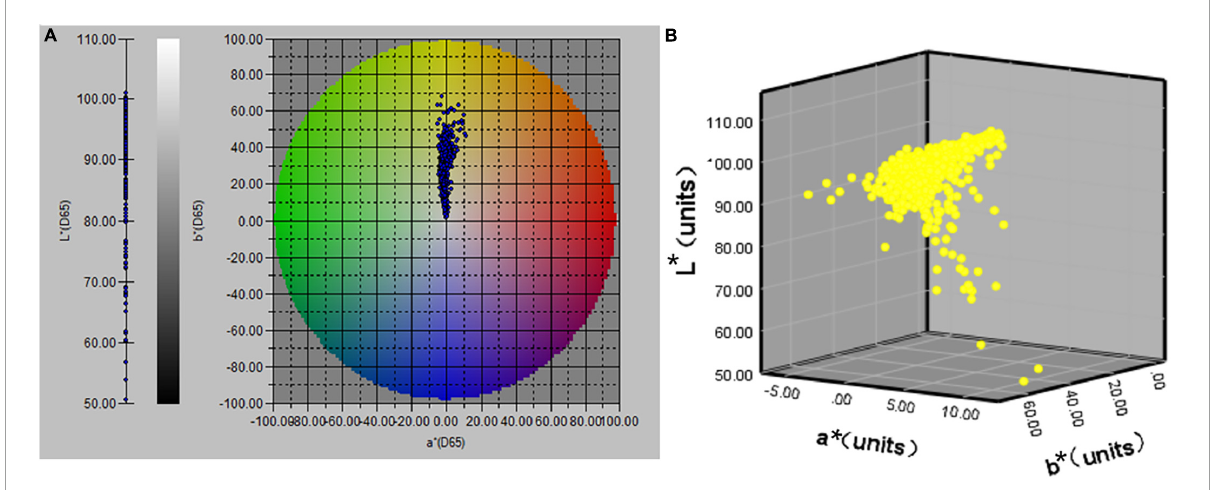
FIGURE1 The distribution map of CIE L*a*b* values of urine samples (n = 803); (A) distribution of L*a*b* values in a 2D space; (B) distribution of L*a*b* values in a 3D space.